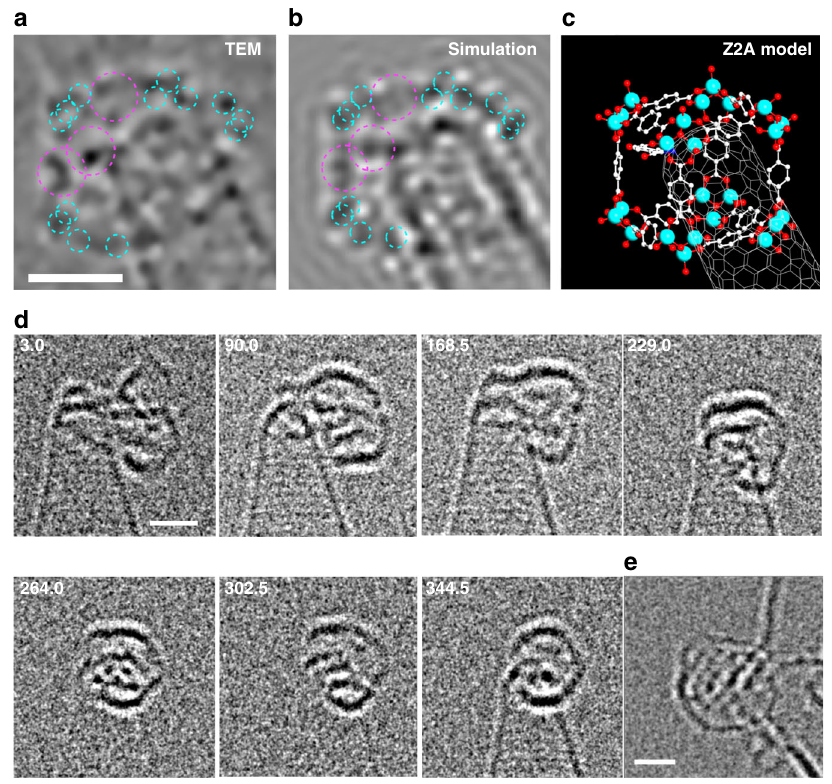
Fig. 5 TEM imaging of MOF-5 and I-MOF-5 PNCs at 0.01 M of Zn 2 + for 21h. a TEM image of a cubic PNC of MOF-5 (methanol wash), b a simulated image, and c a Z2A model corresponding to b . Zinc atoms and benzene rings are circled in the same manner as in Fig. 4. The original video is Supplementary Movie 2. The scale bar is 1nm. d Seven frames from a 345-s video showing the structural reorganisation of a HO I-MOF-5 PNC (dry transfer). The original video is Supplementary Movie 3. The scale bar is 1nm. e A hexagonal-shaped PNC recovered from I-MOF-5 synthesis found in a dry transferred